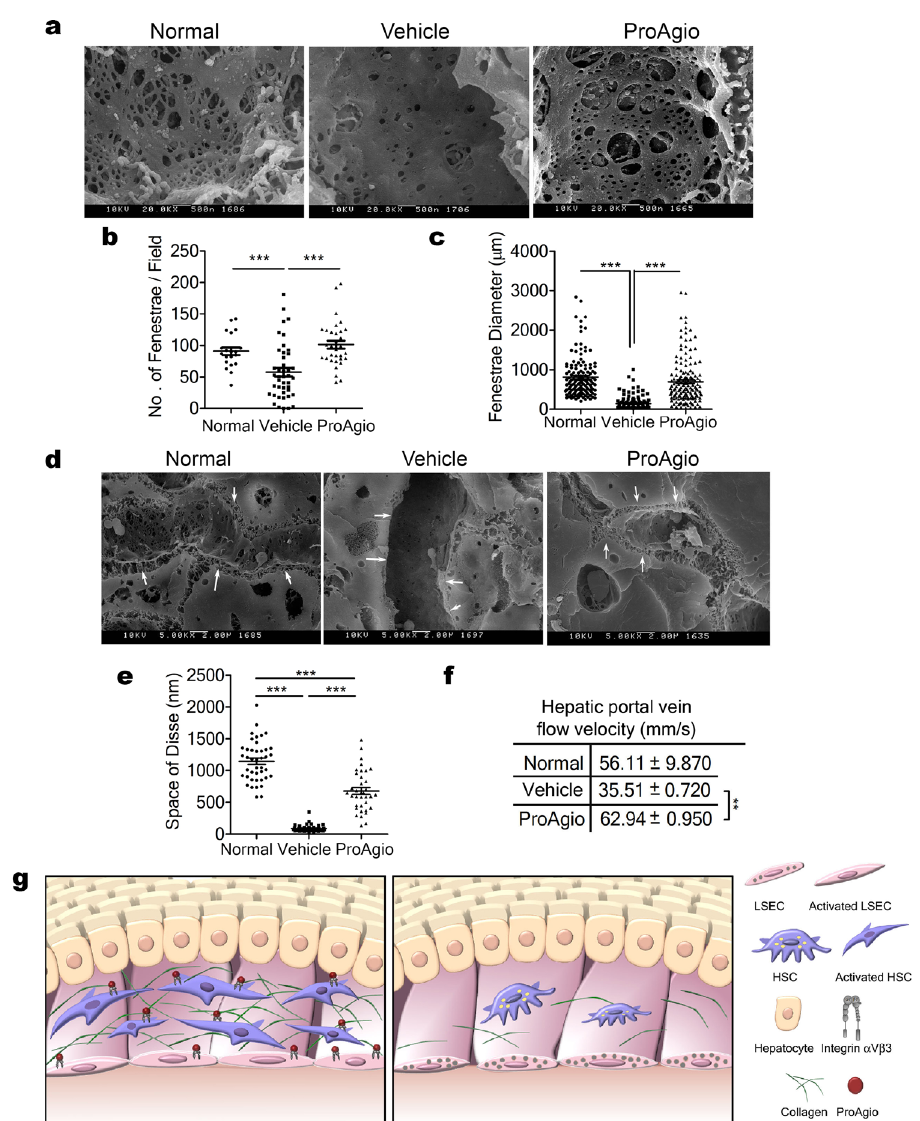
Fig. 6 ProAgio reduces intrahepatic angiogenesis and reverses liver sinusoidal remodeling. a , d Representative SEM images of sections from mice treated with indicated agents. Scale bars are shown 500 nm in ( a ), 2 µ m in d . Arrows in d indicate the space of Disse in SEM images. Quantitation